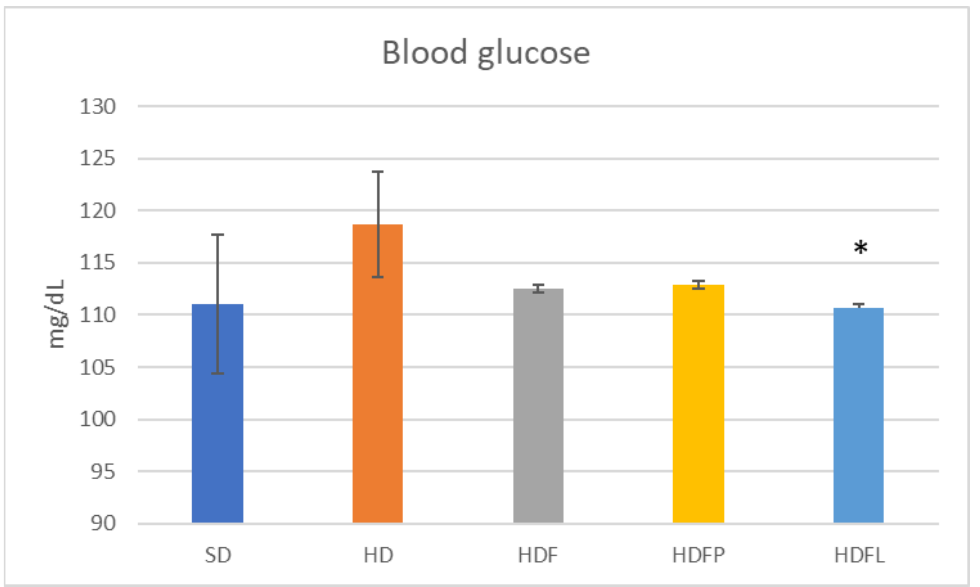
Figure 4. Blood glucose after eight weeks of treatment. Asterisks denote a significant difference vs. HD group ( p < 0.05) after one-way ANOVA and Tukey tests. Error bars are ± standard deviation. Standard diet (SD), hypercaloric diet (HD), hypercaloric diet plus fructans (HDF), hypercaloric diet plus propionate-bioconjugated fructans (HDFP), and hypercaloric diet plus laurate-bioconjugated fructans (HDFL). * p < 0.05.